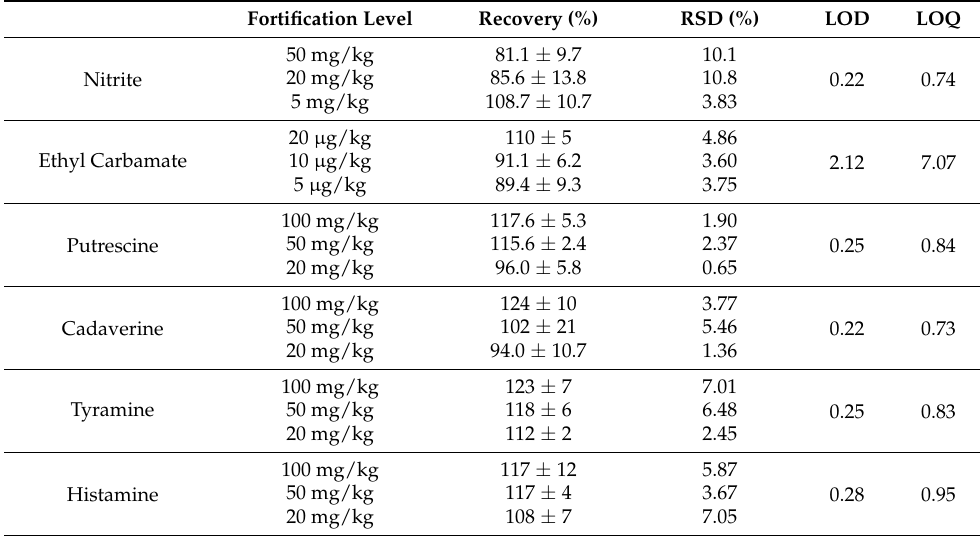
Table 1. Statistical data of method validation tests for nitrite, ethyl carbamate, and biogenic amines. RSD: relative standard deviations; LOD: limit of detection;LOQ: limit of